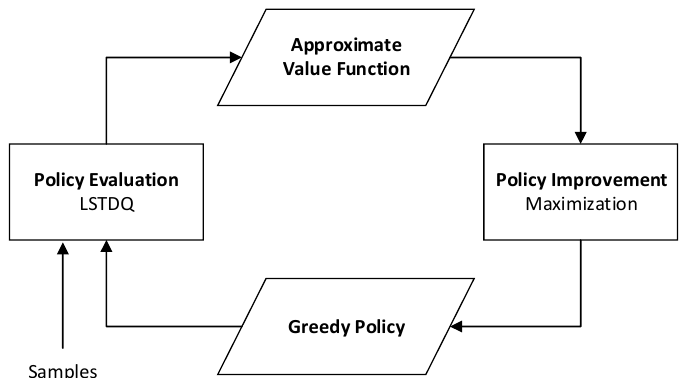
Figure 4. The flowchart of least-squares policy iteration. LSTD Q : least-squares temporal-difference learning for the state-action value